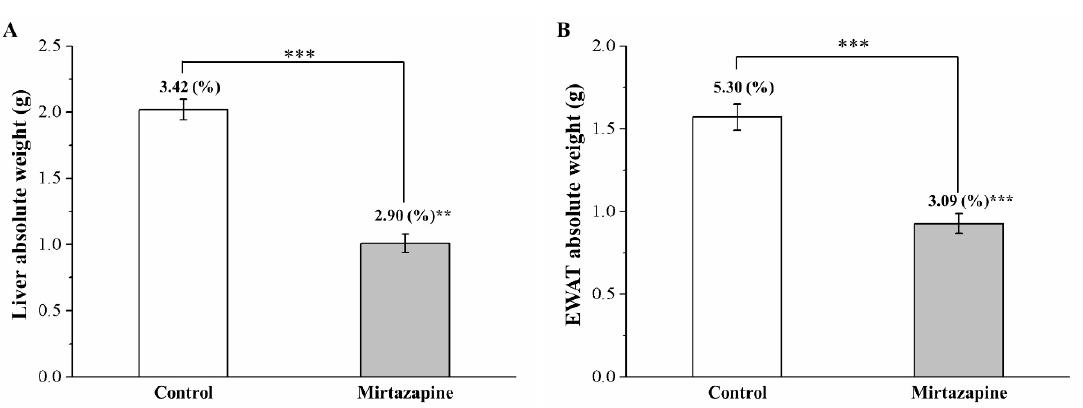
Figure 2 . Changes in absolute weights (g) and body-weight-normalized weights (%) of ( A ) the liver and ( B ) the epididymal white adipose tissue (EWAT) in the control and 10 mg/kg/day mirtazapine-treated mice over the 28 treatment days. We present all data in this figure as mean ± SEMs (n = 10) for both groups. ** p < 0.01, *** p < 0.001.